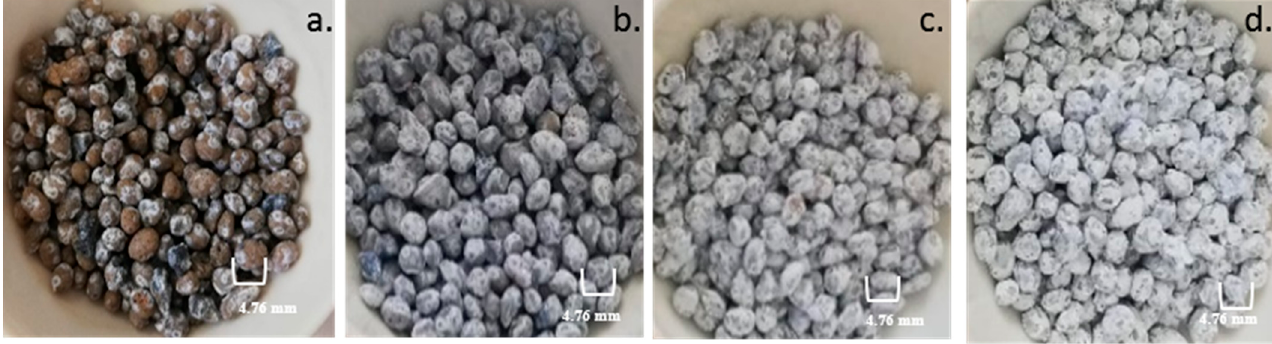
Figure 5. Morphology of photocatalysts prepared with ( a ) 1%; ( b ) 3.6%; ( c ) 5% and ( d ) 10%.